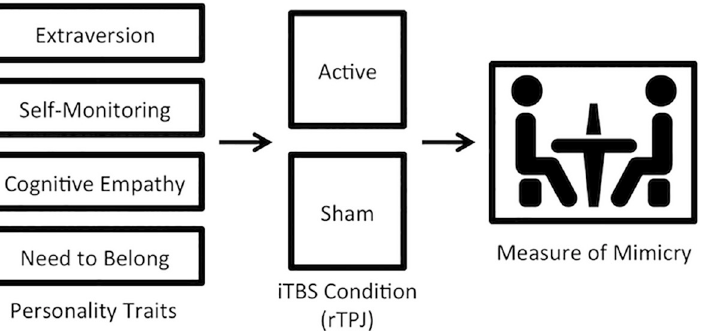
Fig 1. Schematic diagram of experimental procedure. Before the study session, participants completed an online questionnaire assessing demographic information as well as measuring personality traits that have been known to predict mimicry. When participants arrived for the study session, they were randomized to receive either active stimulation or sham stimulation to the right temporoparietal junction (rTPJ). Immediately following stimulation, participants interacted with a confederate in a 10-minute task that involved describing photos to one another. While they interacted, the confederate constantly touched her hair and face. The amount of time that participants touched their hair and face was measured by filming participants before the confederate was brought in (baseline) as well at while interacting with the confederate. The ratio of time spent touching hair and face during the social interaction relative to baseline was computed as a measure of how much the participant mimicked the